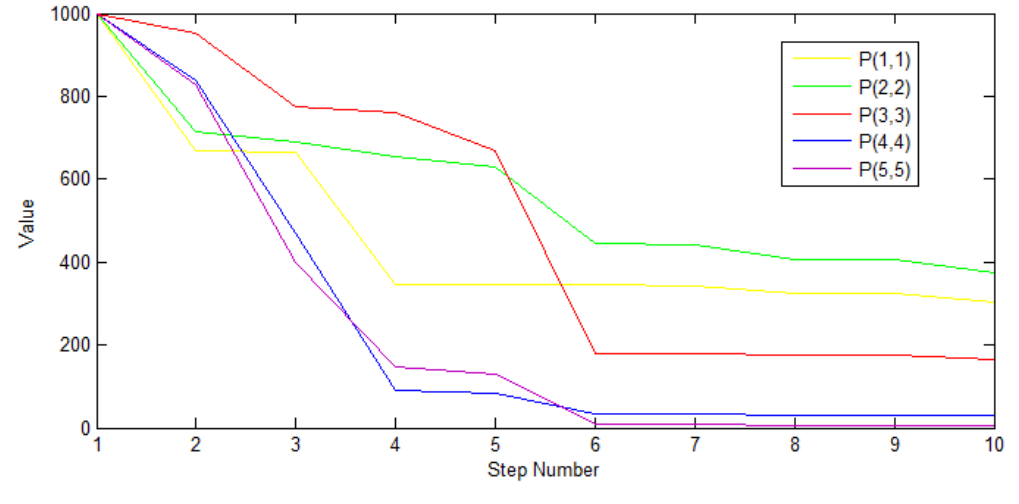
Figure 6. Convergence of diagonal elements of covariance matrix P .